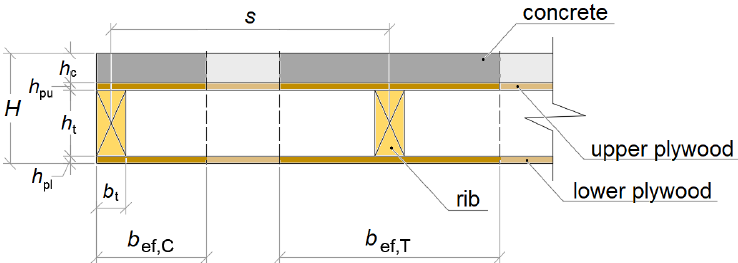
Figure 7. Two types of effective sections for calculations, where H —the height of the panel; h c —the height of the concrete layer; h pu and h pl —the height of the upper and lower plywood layers; h t —the height of the timber rib; b ef, T is the effective width of the double-T section, equal to the smallest of a tenth of the panel span L with rib width b t and half of rib step s ; the effective width of the C-type section b ef,C is half of b ef,T with ½ b t .